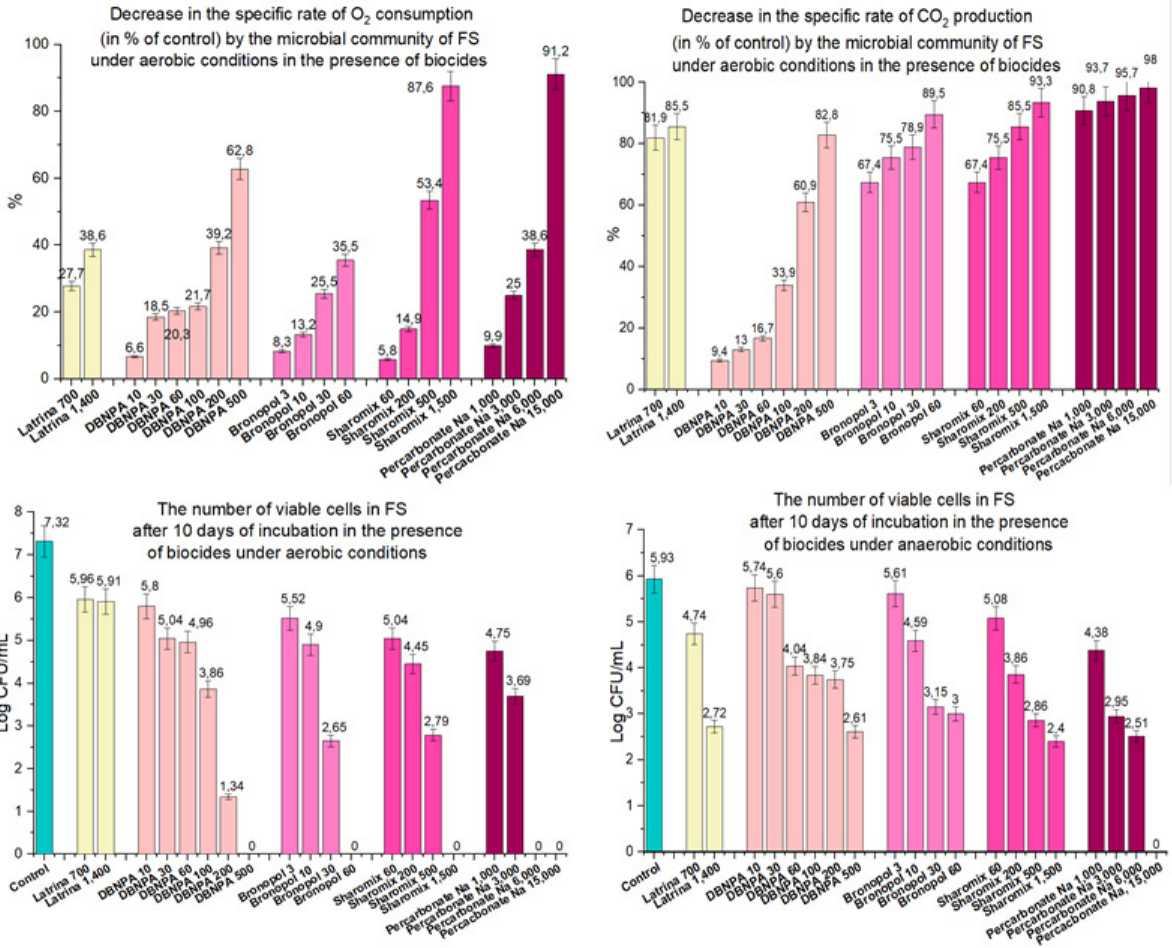
Figure 7. Comparison of biocidal effects of “Latrina” with DBNPA, bronopol, Sharomix and sodium percarbonate.